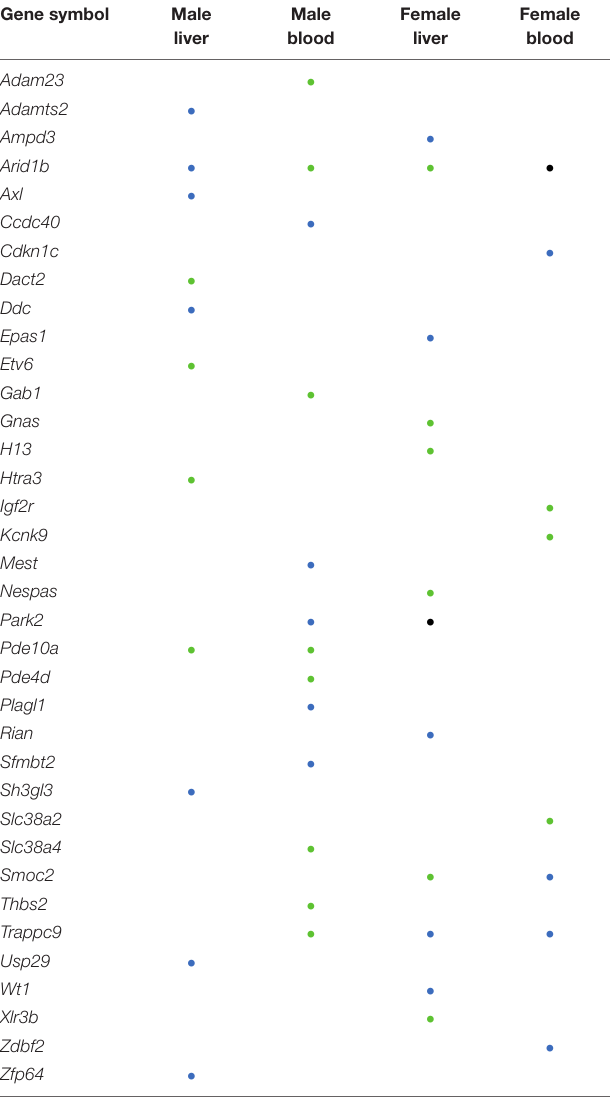
TABLE 1 | Imprinted genes with differentially methylated regions (DMRs). Gene